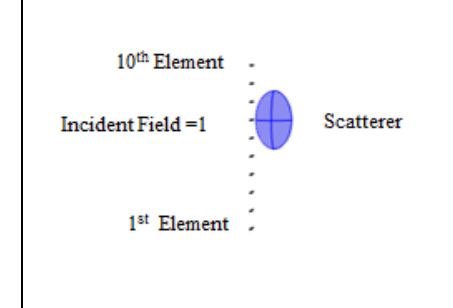
Figure 3: Geometric setup for case 1